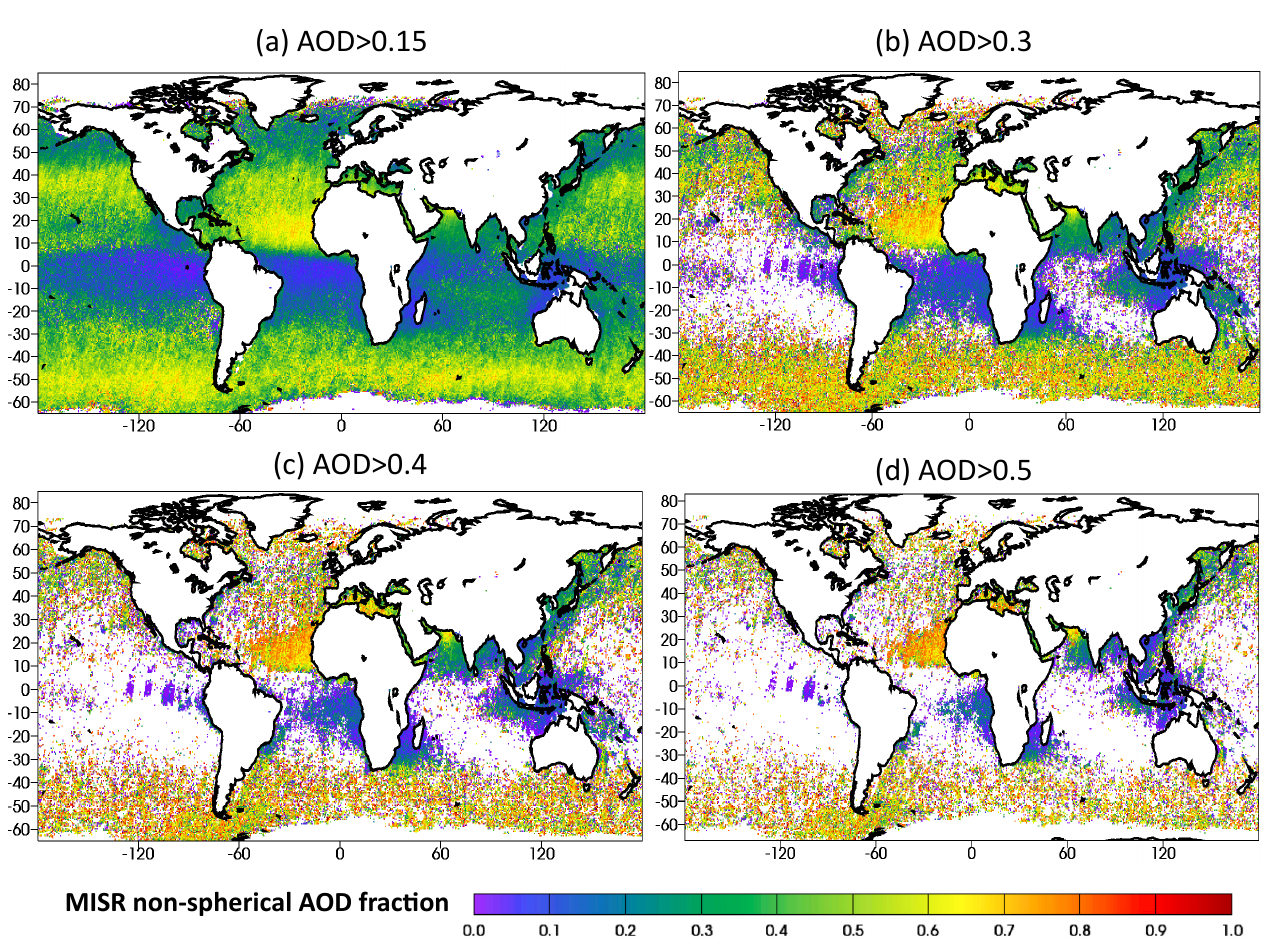
Fig. 5. Climatology of MISR V22 non-spherical AOD fraction for the month of October over dark water for different AOD ranges: (a) AOD > 0.15, (b) AOD > 0.3, (c) AOD > 0.4, (d) AOD > 0.5. This figure illustrates that the bands of enhanced non-sphericity are not simply due to reduced algorithm sensitivity at low